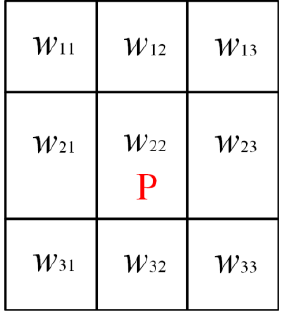
Figure 2. k × k distance weighted convolution template W (k = 3).